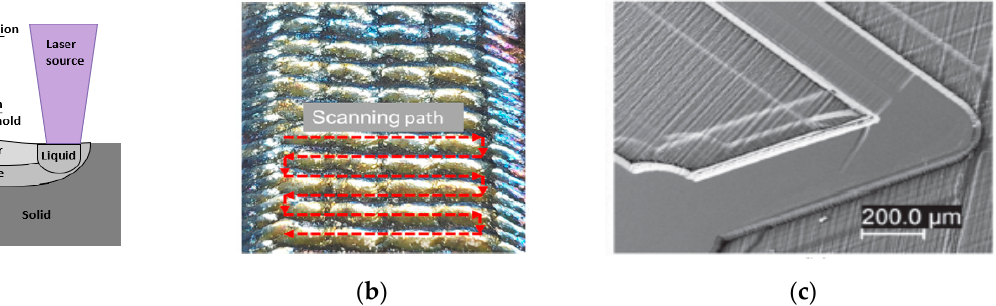
Figure 6. ( a ) Laser working principle (after Perry 2007) [85], ( b ) low and high power laser to